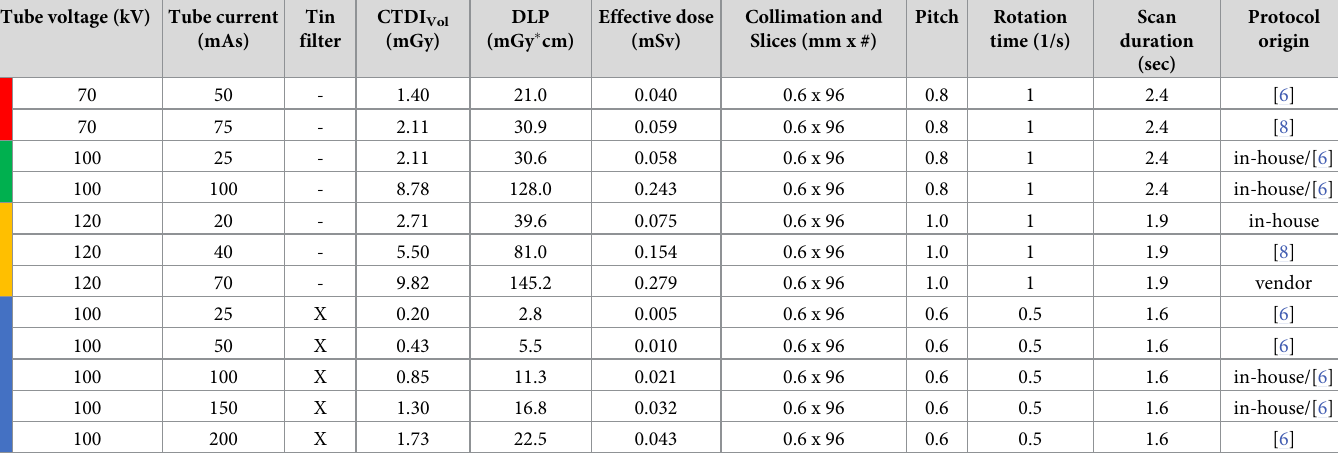
Table 1. CT acquisition parameters. Tube voltage (kV) Tube current